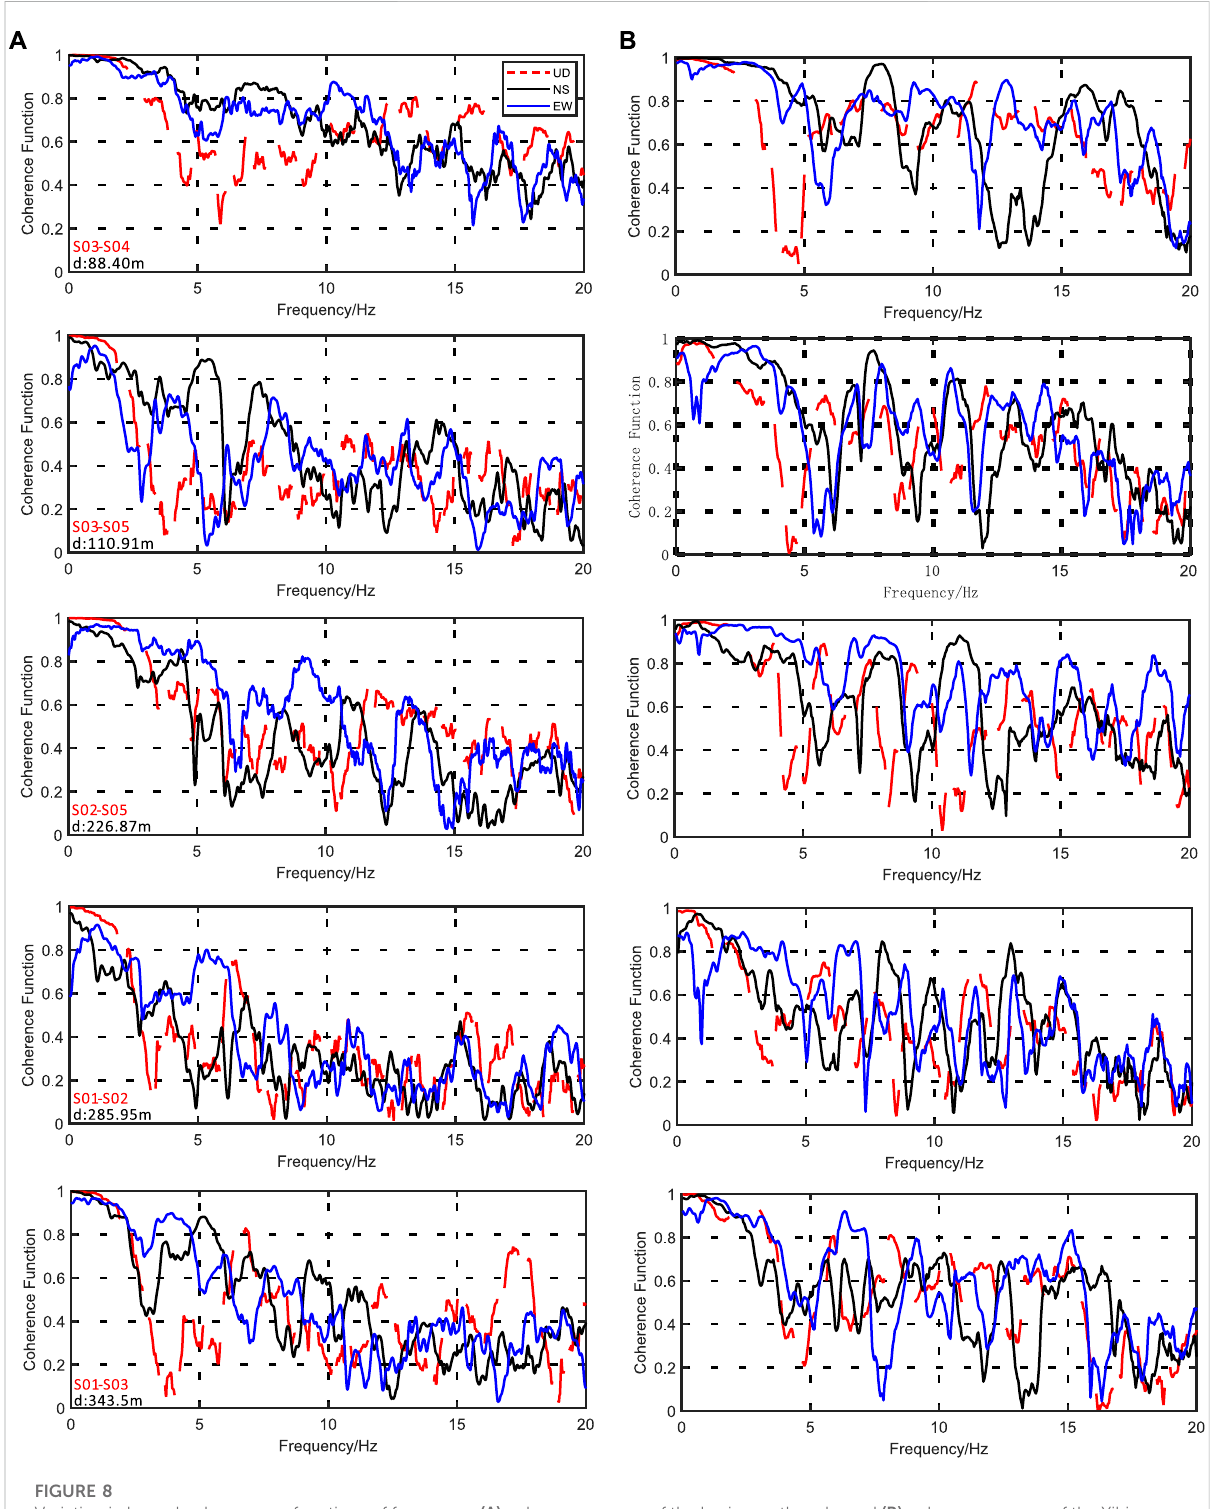
FIGURE 8 Variation in lagged coherency as functions of frequency: (A) coherency curves of the Luxian earthquake and (B) coherency curves of the Yibin earthquake.